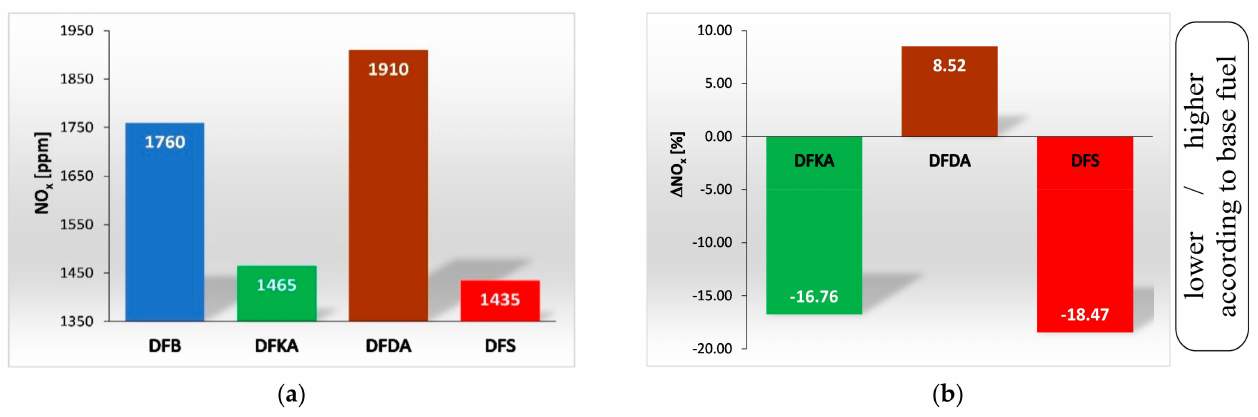
Figure 11. ( a ) Concentration of NO x in exhaust gas for tested fuels. ( b ) Percent change in concentra- tion of NO x ( ∆ NO x ) for tested fuels relative to NO x for DFB (base